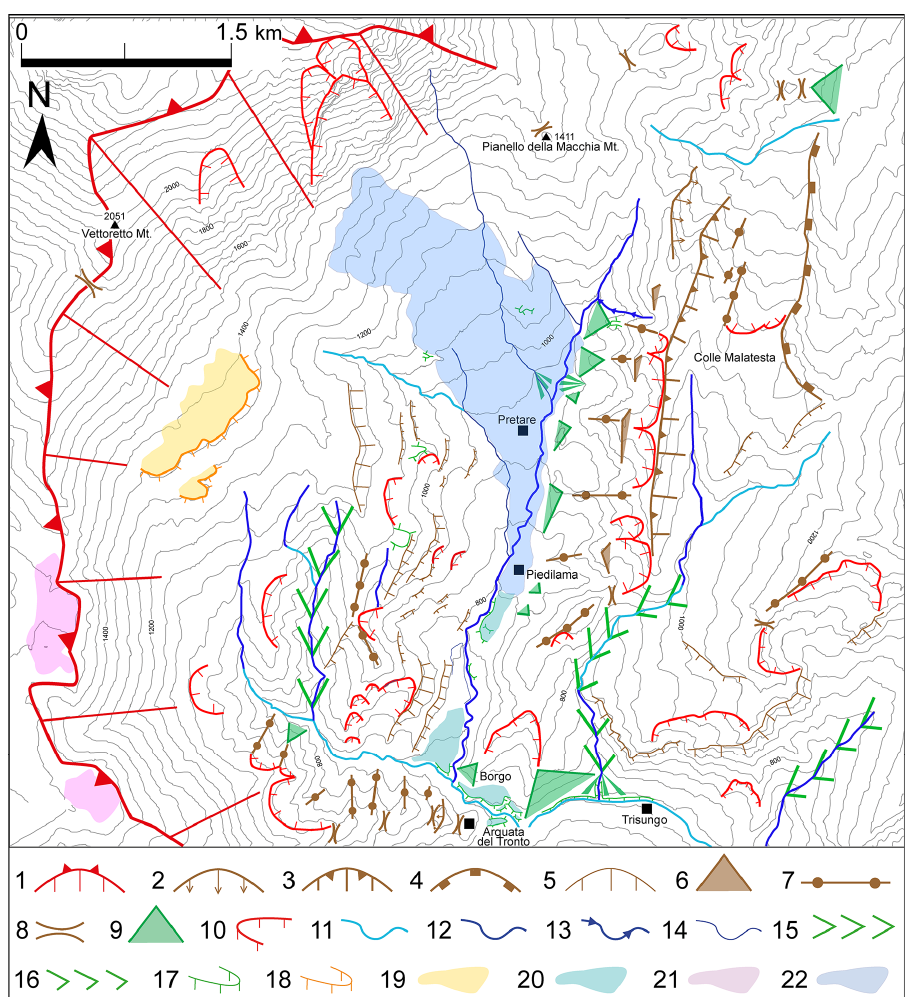
Figure 4. Geomorphological sketch map of the study area. Legend: (1) obsequent fault slope; (2) structurally ‐ controlled slope; (3) hogback; (4) homoclinal ridge; (5) litho ‐ structural scarp; (6) flat iron; (7) straight ridge; (8) saddle; (9) triangular facets; (10) degradational and/or landslide scarp; (11) transverse stream; (12) strike stream; (13) anti ‐ dip stream; (14) consequent stream; (15) V ‐ shaped valley; (16) asymmetric valley; (17) fluvial terrace scarp; (18) glacis scarp; (19) fluvial terrace tread; (20) glacis surface; (21) erosional surface; (22) Pretare rock avalanche area.